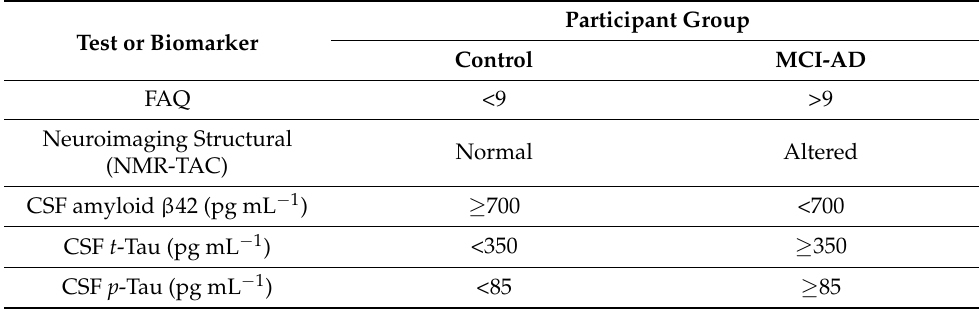
Table 1. Cont. Participant Group Test or Biomarker Control MCI-AD FAQ <9